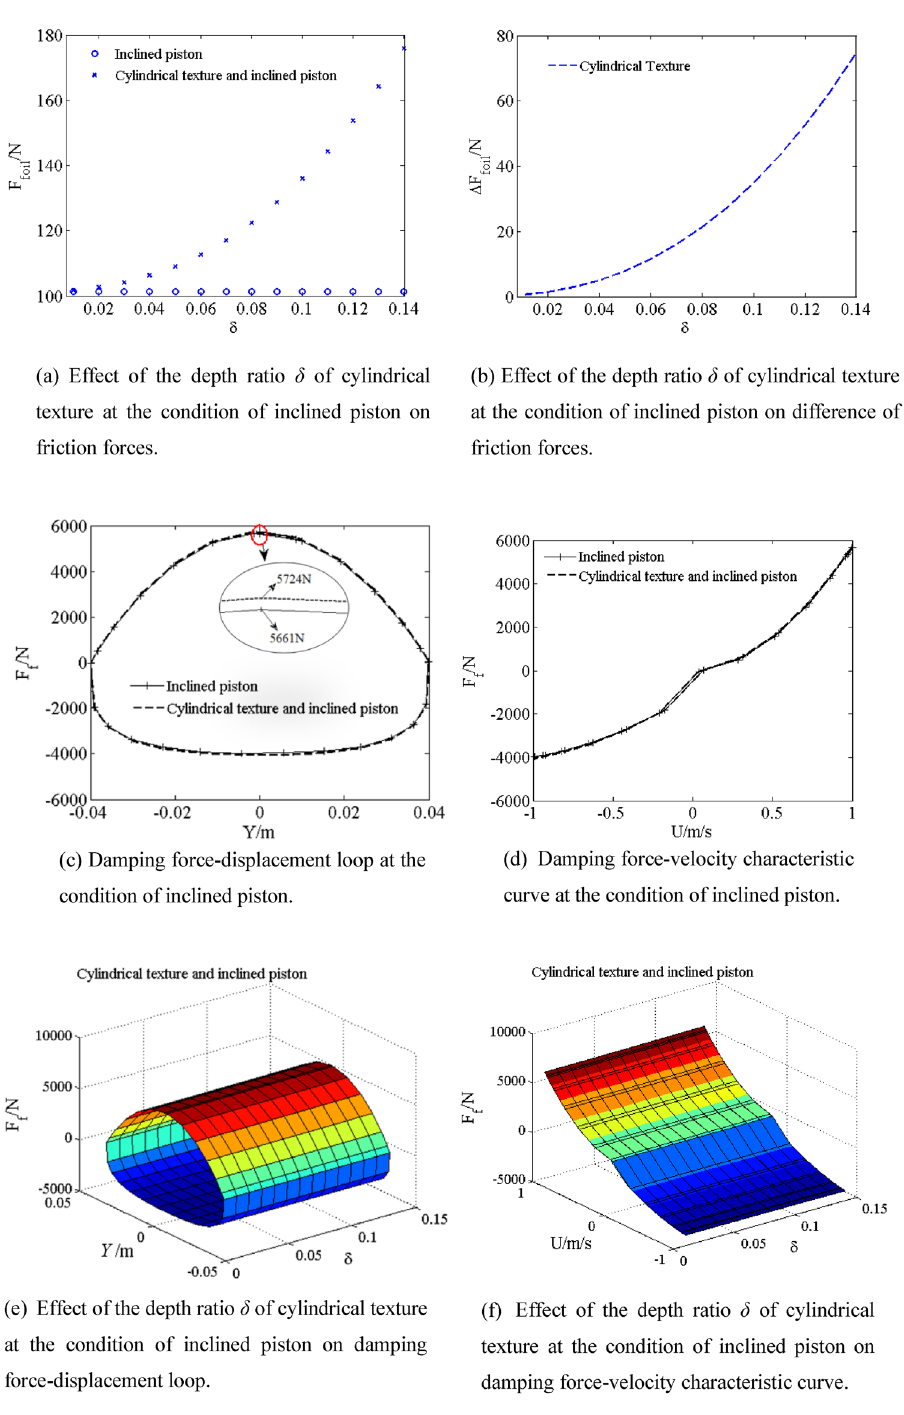
Figure 9. Effect of the depth ratio δ of cylindrical texture at the condition of inclined piston on damping ratios S p is increased to 0.18, the friction force F foil of the cylindrical textured inclined piston (154.1 N) greatly increases by 52.27%. The cylindrical textured at inclined piston condition has great effects on friction force. When piston is eccentric, the eccentricity e of the central section of the piston is 0.6h 0 . The friction force F foil of the eccentric piston and the cylindrical textured eccentric piston are shown by simulating with different area ratios S p from 0.0003 to 0.18 in Fig. 13c, the difference Δ F foil of friction force of the cylindrical texture eccentric piston and eccentric piston is shown in Fig. 13d. The friction force F foil of the cylindrical texture eccentric piston increases with increasing area ratios S p from 0.0003 to 0.18. F foil - S p curves are approximately linear. Compared